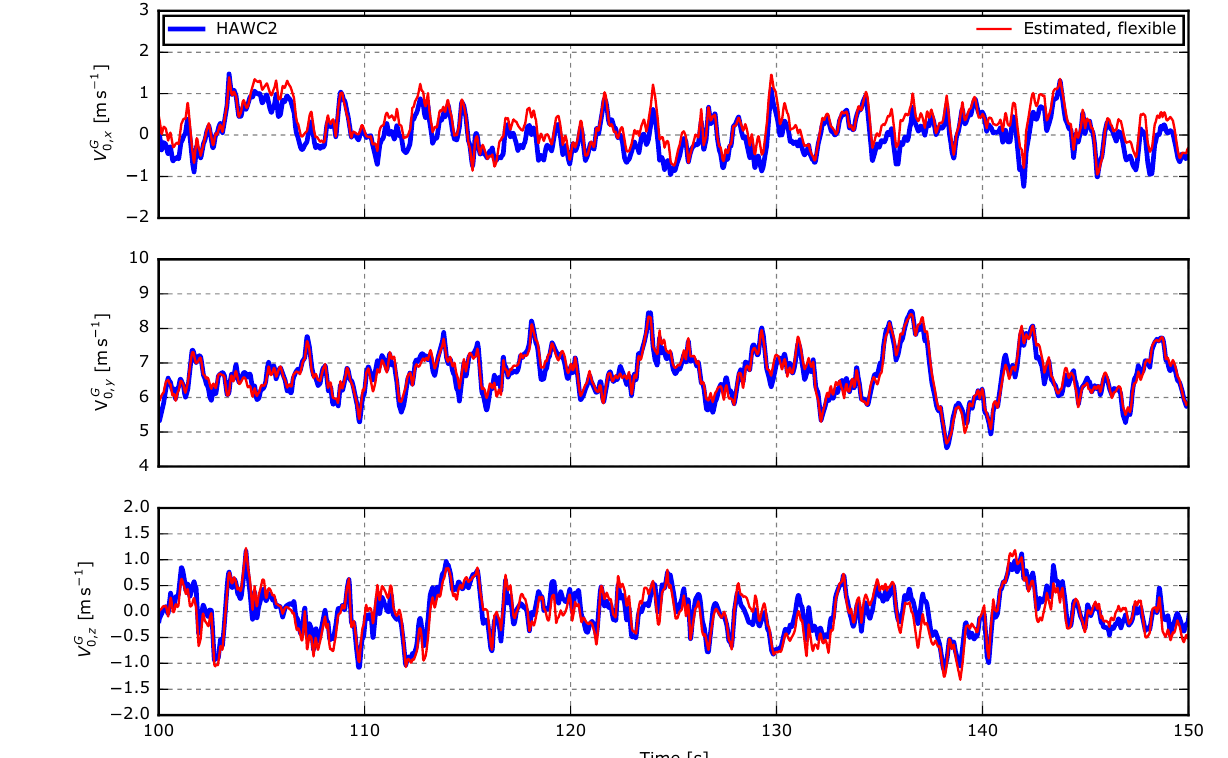
Figure 15. HAWC2 results include the free wind speed estimated in turbulent inflow for a flexible structural model (Case